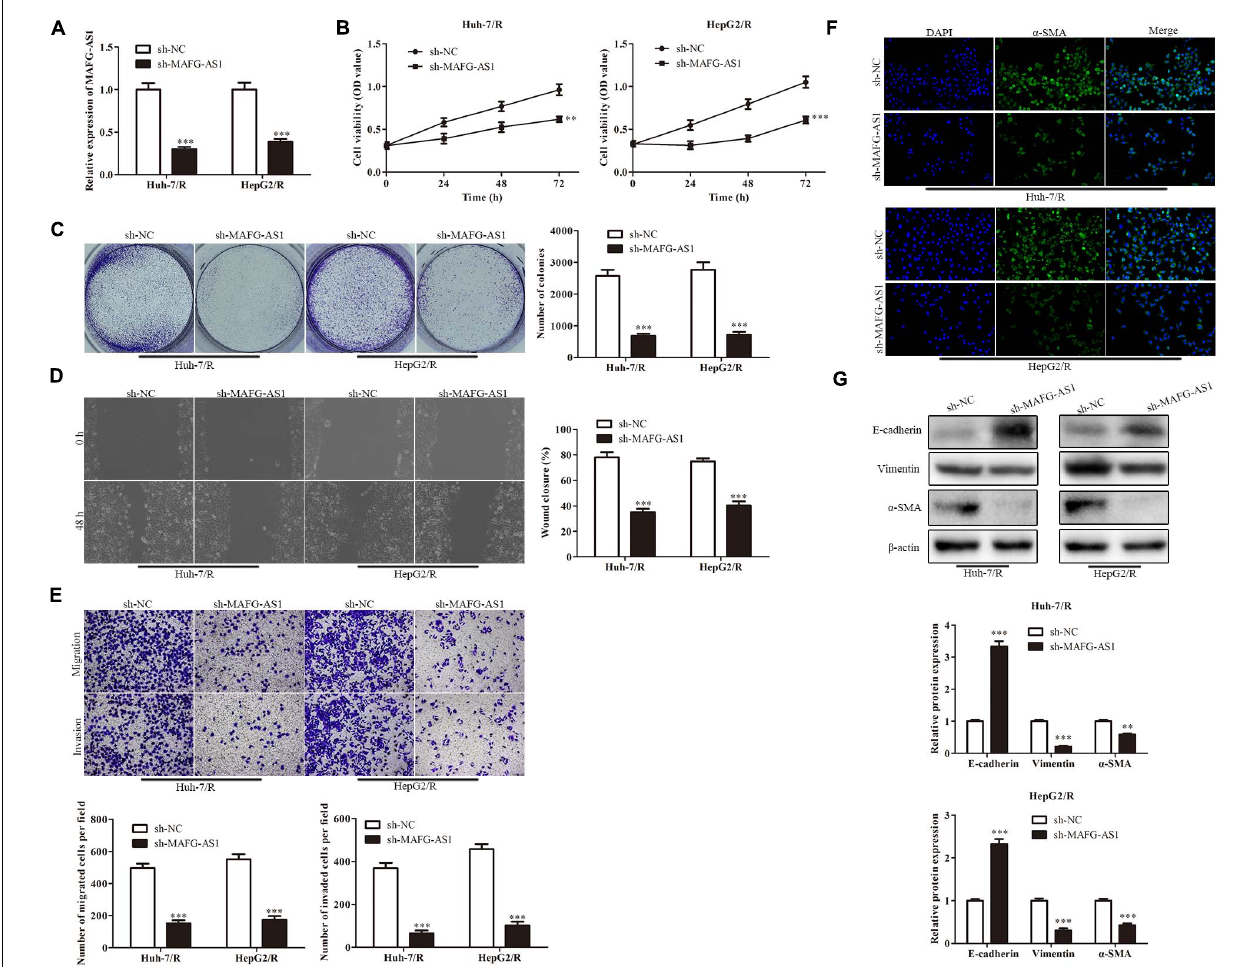
FIGURE 2 | MAFG-AS1 knockdown inhibits proliferation, invasion, migration, and EMT of HCC cells. (A) RT-PCR analysis was used to verify the interfering efficiency. (B) CCK-8 assay indicated the cell viability in the sh-MAFG-AS1 group compared with the sh-NC group. (C) The clone formation abilities of the Huh7/R and HepG2/R cells. (D,E) Wound healing assay (D) and transwell analysis (E) to test the effect on the invasion and migration of HCC cells. (F,G) Immunostaining (F) and western blotting (G) detected the EMT of Huh7/R and HepG2/R cells. Scale bars: 50 µ m. ** P < 0.01, *** P < 0.001 vs sh-NC group.